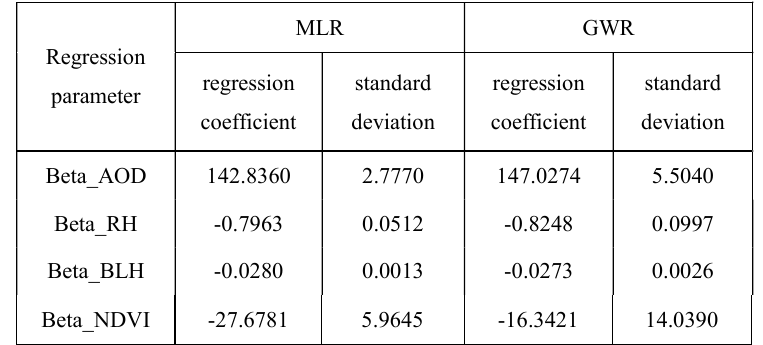
Table 3. Statistics of geographically weighted and multiple linear regression